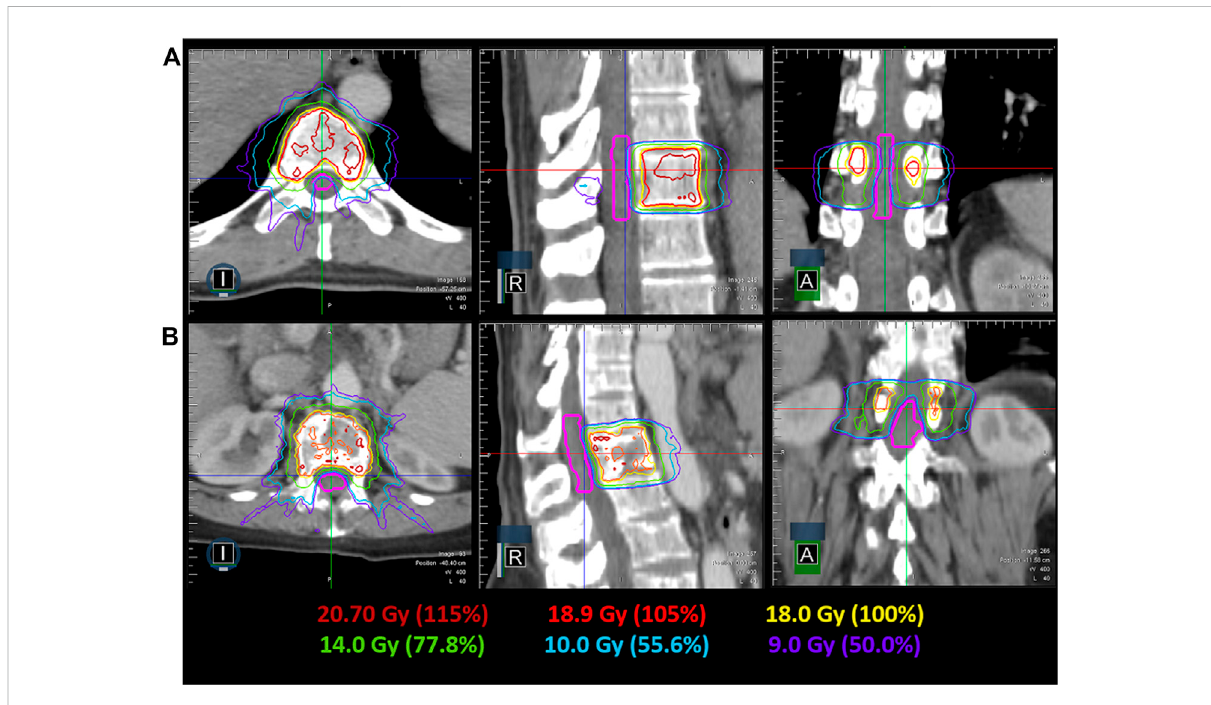
FIGURE 4 Achievable dose distribution in the axial, coronal and sagittal view for a T10 (A) and L1 (B) spine SRS plan. The spinal cord contour is shown in pink, while the relevant isodose lines are indicated by their